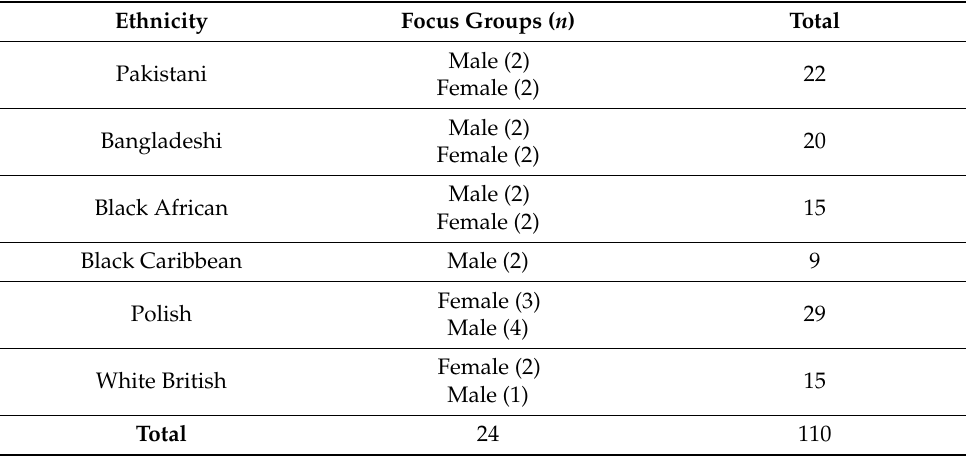
Table 1. Sample breakdown for all focus groups by ethnic